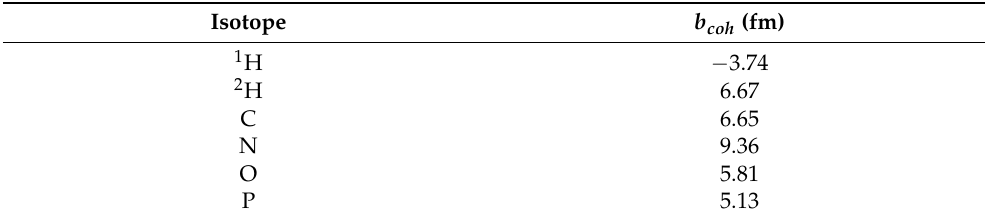
Table 1. Coherent scattering lengths ( b coh ) of isotopes of interest for biological membranes [52]. If no specific isotope is noted, the value provided is for the natural abundance of stable isotopes. Isotope b coh